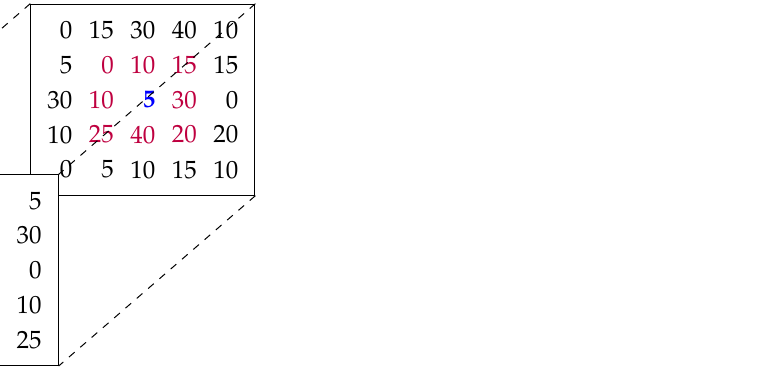
Figure 2. Sample data grid at a time step t . The location of the weather station is ( 3,3 ) (i.e., i = 3 and j = 3) and the diameter d is also 3. The values from the neighborhood are